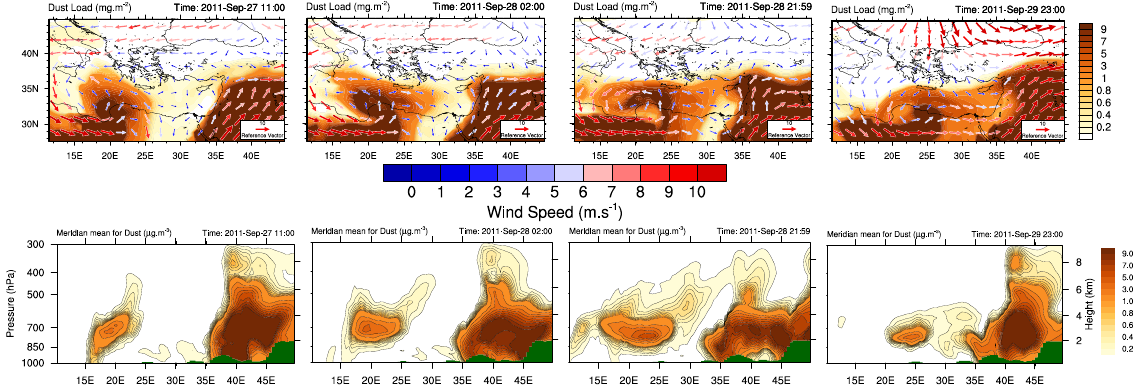
Figure 9. Time series of (top) dust load and (bottom) meridional mean for the second event at CUT-TEPAK location (34.675 ◦ N). The green shaded area represents the orog- raphy.